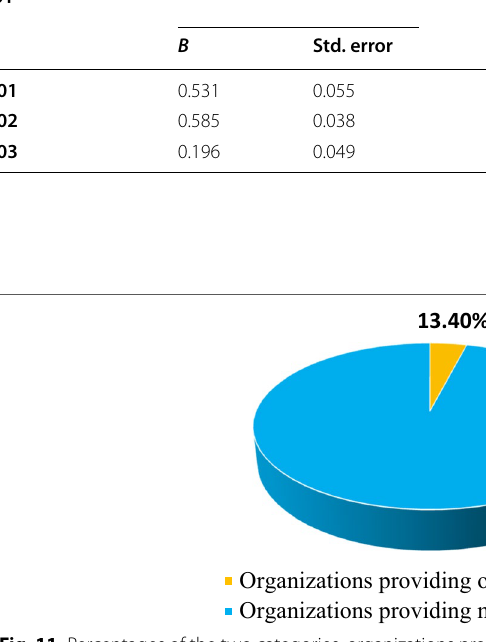
Table 7 Multiple regression analysis of the three hypotheses Hypotheses